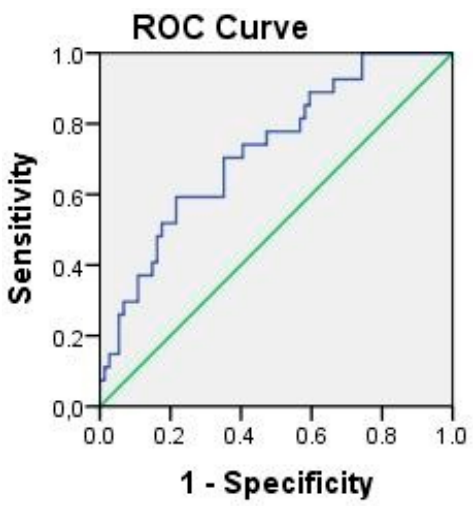
Figure 3. ROC curve for FMD impairment—predicted probability of synergistic effect of B2GPIgG, hsCRP, and ADMA.